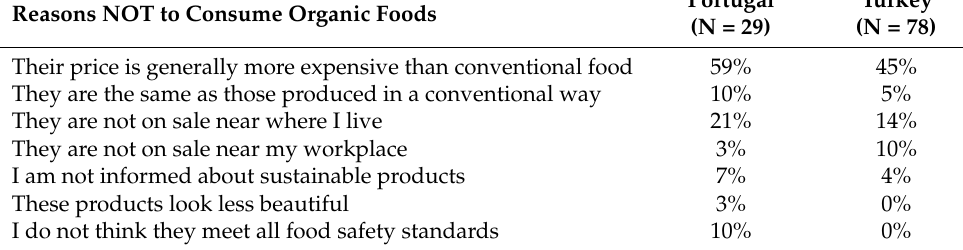
Table 4. Reasons pointed out by the participants not to consume organic foods (N represents the number of participants in each country that do not consume organic foods).